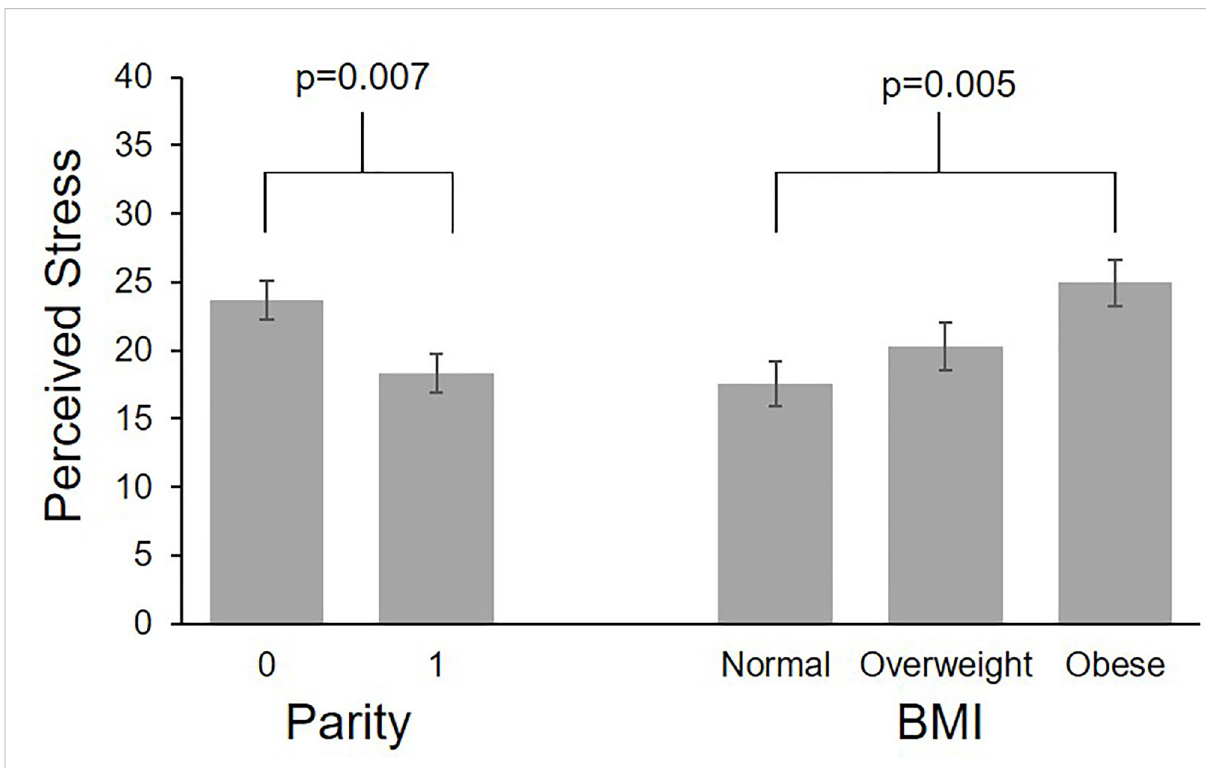
FIGURE 3 Differences in perceived stress by parity and pre-pregnancy BMI. Values are least square means ± standard error from multilevel models controlling for study group and gestational